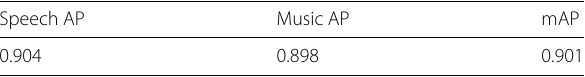
Table 9 Average precisions per class and mean average precision of the best obtained system Speech AP Music